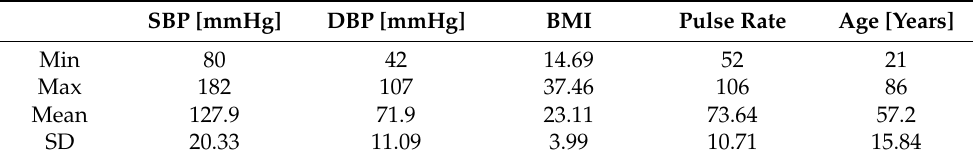
Table 6. Statistical information of the dataset.